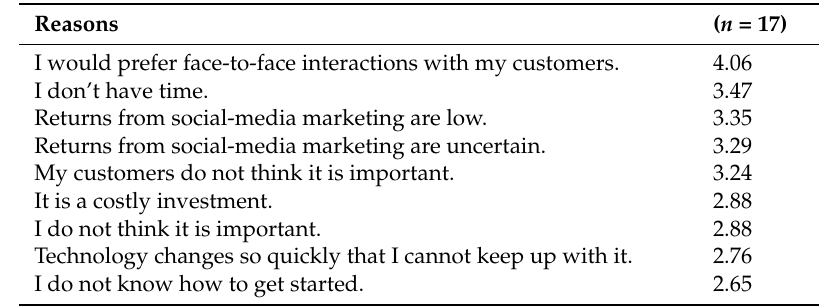
Table 8. Reasons “why not using social-media marketing” of ornamental horticulture industry respondents in the study questionnaire a